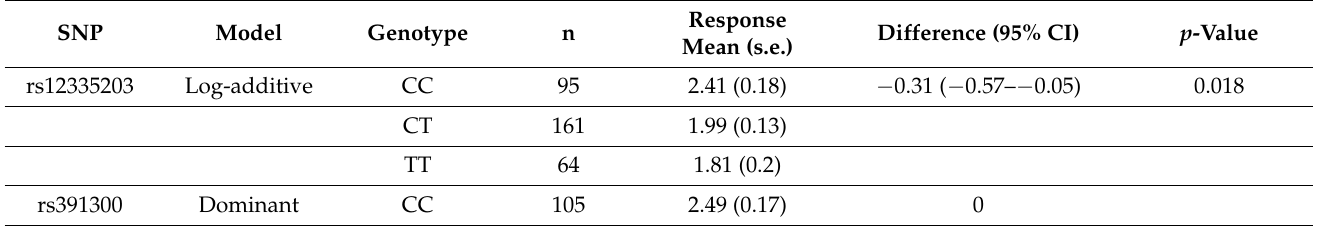
Table 3. Analysis of association of SNPs with levels of loneliness (SOLTOT) based of lineal regression. The models with significant p and the lowest Akaike’s Information Criterion (AIC) and Bayesian Information Criterion (BIC) are